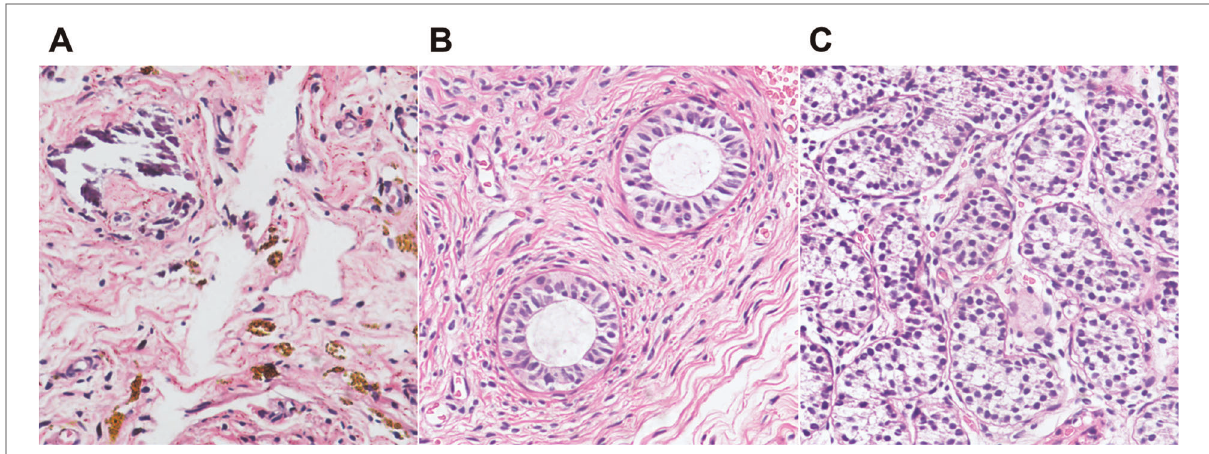
FIGURE 6 Photomicrographs of testicular degeneration syndrome. ( A ) Fibrous tissue with hemosiderin and calci fi cations (H&E, ×20). ( B,C ) H&E stains showing epididymal tissue (B, ×20) and seminiferous tubules (C, ×20) in the remnants.